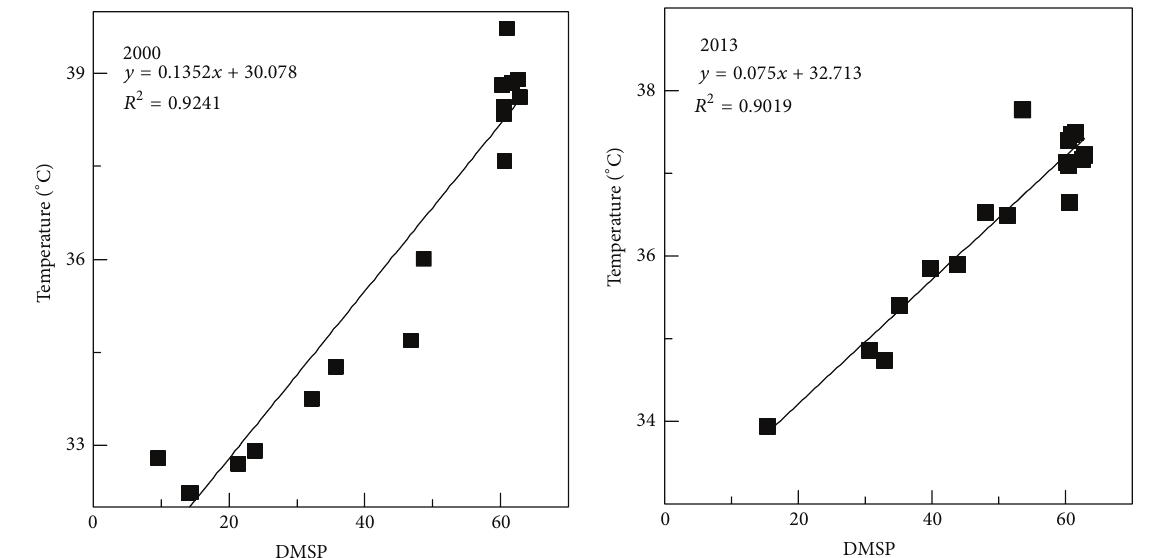
Figure 10: Correlation between LST and DMSP ( 𝑥 : mean DMSP; 𝑦 : mean LST).